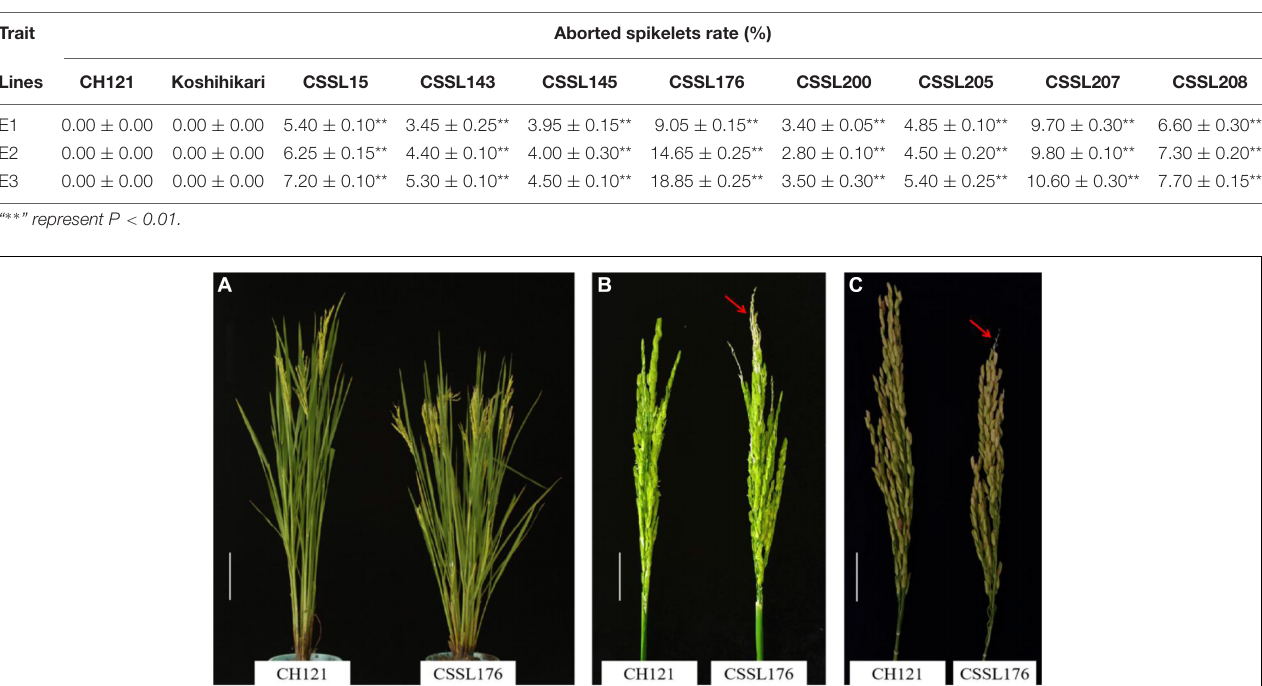
FIGURE 1 | Phenotypes of the CSSL176 and CH121. (A) Plants at the heading stage, Bar = 16 cm. (B) Panicles at the heading stage. Bar = 4 cm. (C) Panicles at maturity period, Bar = 3 cm. The arrows show the PAA in CSSL176.